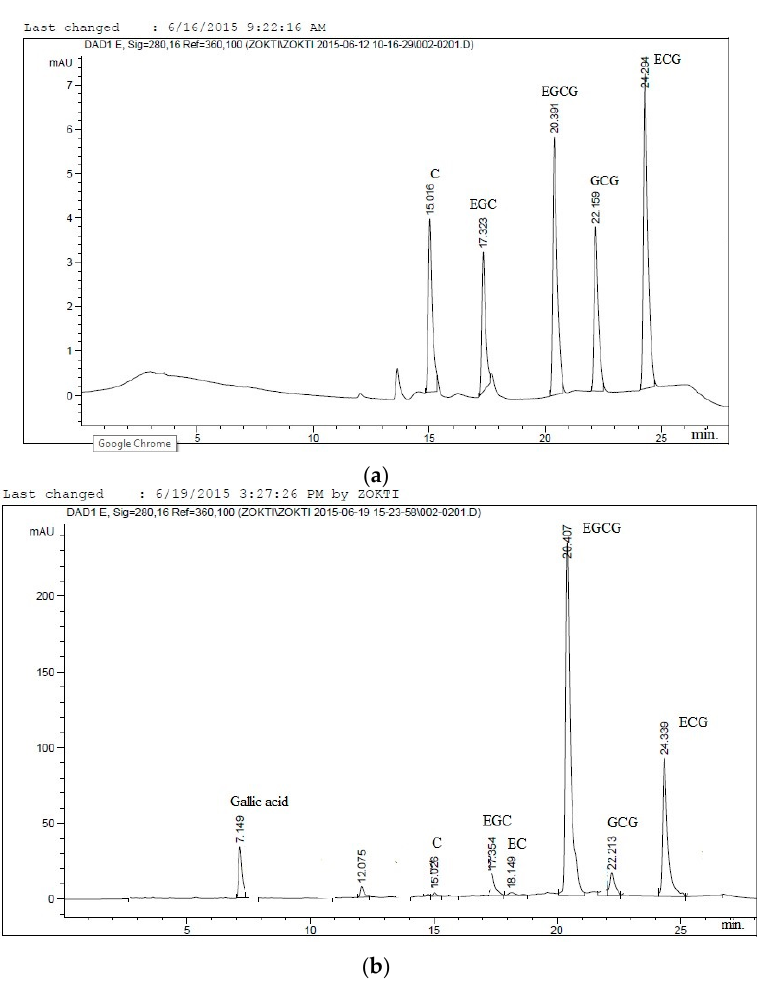
Figure 2. HPLC chromatograms ( a ) catechin standards; ( b ) chromatograms from in vitro studies.